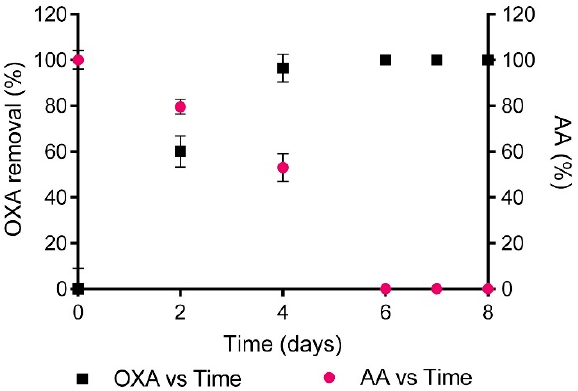
Figure 2. Evolution of oxacillin concentration and antibacterial activity (AA) as a function of the operating time during the biological degradation process by Leptosphaerulina sp. Reprinted with permission from ref. [20]. Copyright 2018 Elsevier.